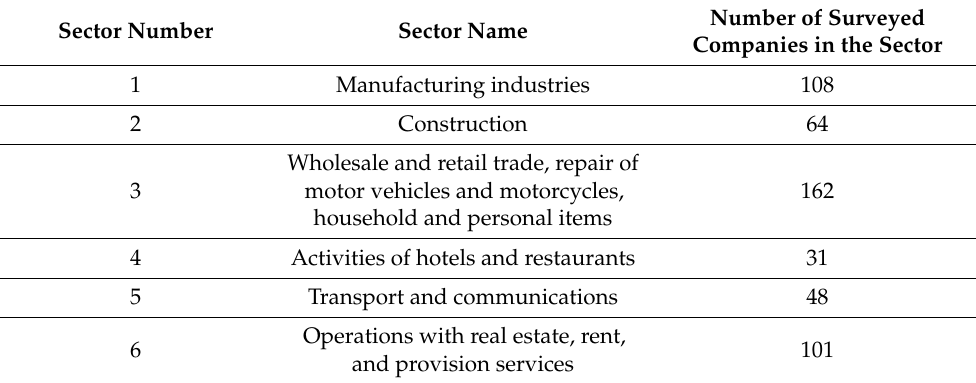
Table 2. Economic structure of a single-industry town. Sector